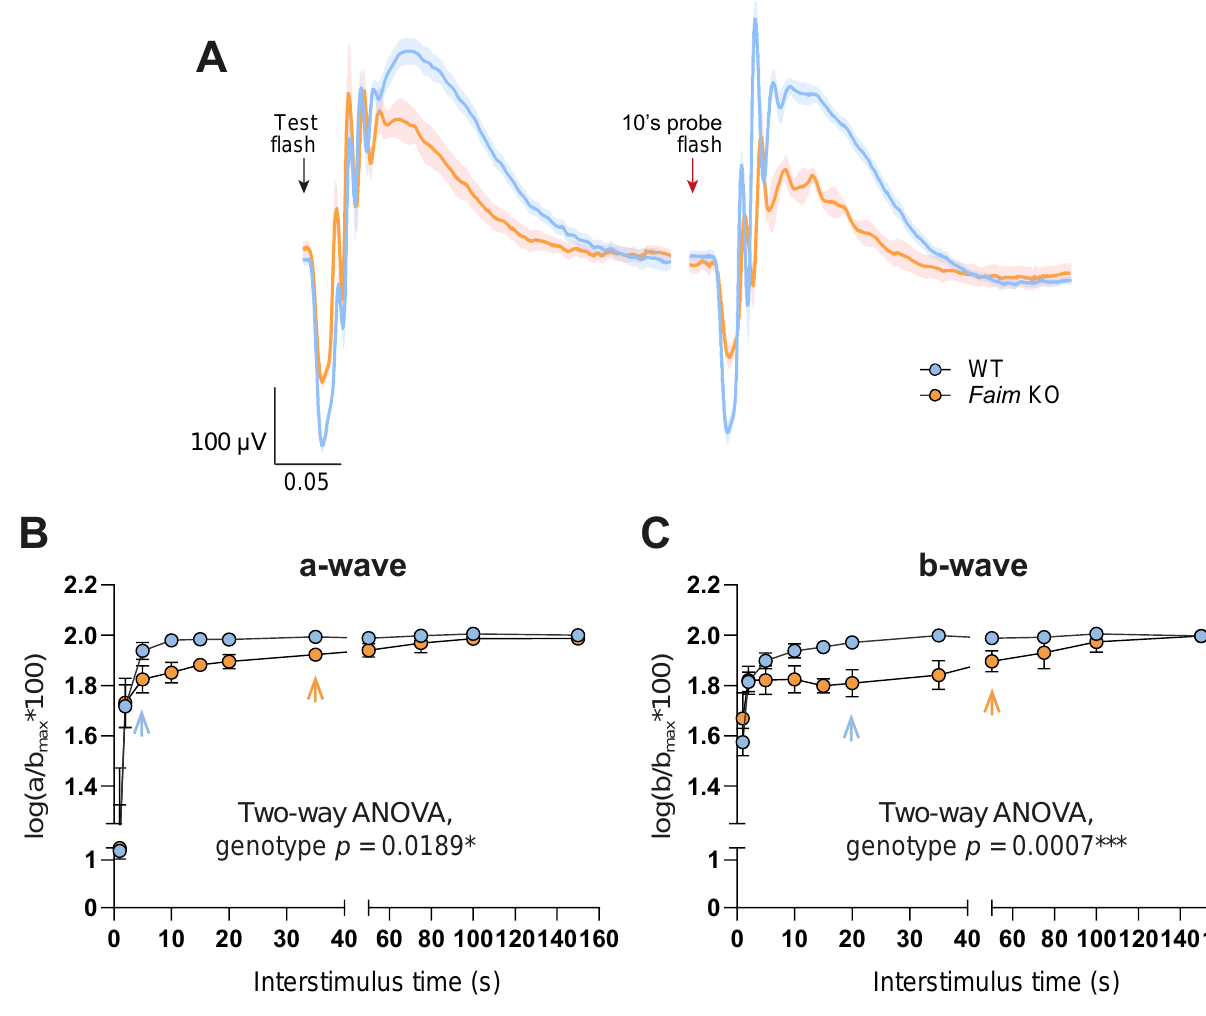
Figure 5. Delay in dark adaptation in Faim KO mice is maintained at 18 months of age. ( A ) ERG responses at 1.5 log cd·s/m 2 after test flash and 1 0′ s probe flash. Data are plotted as the mean (solid line) and SEM deviation (shaded area) of each condition. ( B , C ) Graph representing the delay in dark adaptation found in the mixed a-wave ( B ) and b-wave ( C ) of Faim KO mice in comparison to WT mice. Data are plotted as mean and SD and represented as log(a/a max *100) or log(b/b max *100) to interstimulus time, where “a max ” and “b max ” are the a- and b-wave after the test flash, and “a” and “b” are the a- and b-wave after the probe flash. Statistical analysis was performed using two-way ANOVA. n = 6–7 mice/group. * p < 0.05, *** p < 0.005.